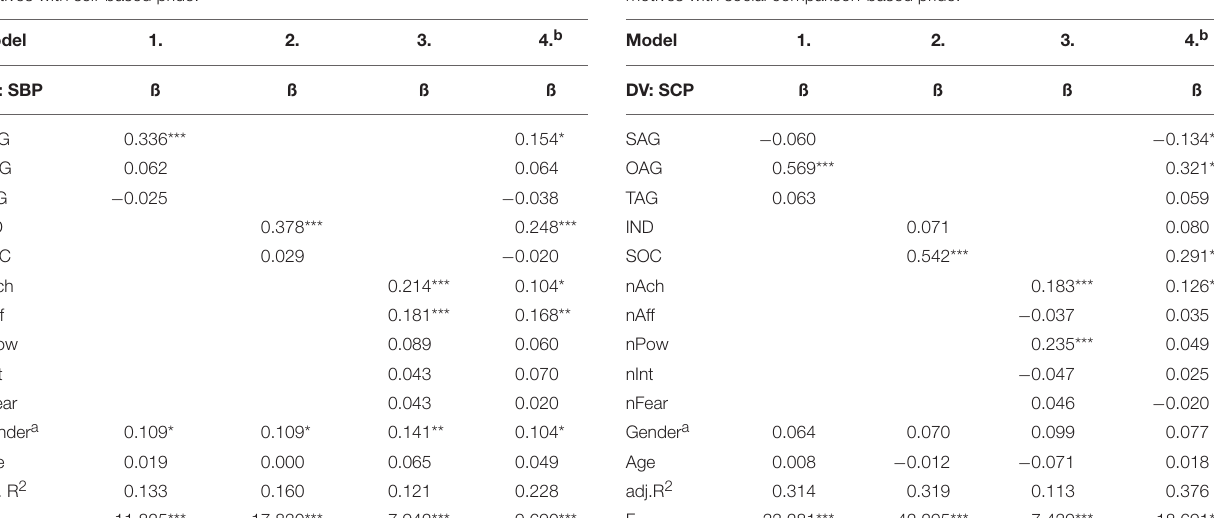
TABLE 3 | Relation of self, other, and task-approach goals, individual and social achievement values, and explicit achievement, affiliation, power, intimacy, and fear motives with social comparison-based